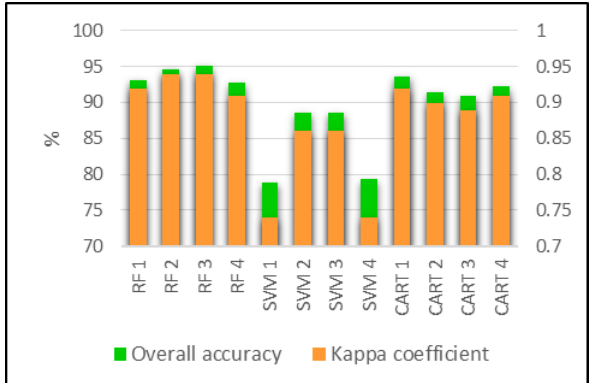
Figure 5. Comparison of every classifier in term of overall accuracy and Kappa